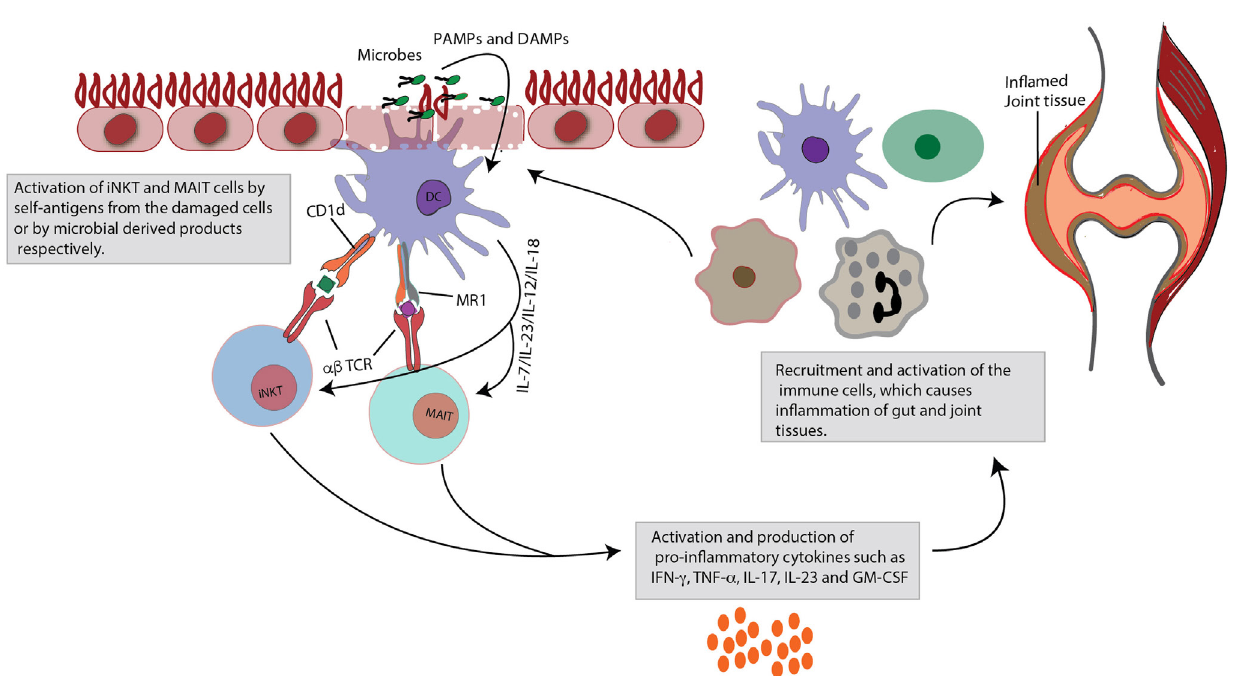
FiGURe 1 | Role of invariant natural killer T (iNKT) and mucosal-associated invariant T (MAIT) cells in gut and joint inflammation. Upon activation, iNKT cells and MAIT cells rapidly produce large quantities of cytokines. This figure focuses specifically on their pro-inflammatory effects. iNKT and MAIT cells are characterized by a semi-invariant T cell receptor (TCR), which can detect ligands of bacterial or self-origin. These antigens are presented by monomorphic MHC class I-like molecules (CD1d for iNKT cells and MR1 for MAIT cells), expressed on dendritic cells (DCs). Next to this TCR-dependent stimulation, the cells can also be activated in a TCR-independent cytokine-induced manner, that is danger-associated molecular pattern (DAMP) or pathogen-associated molecular pattern (PAMP) mediated. Activation is quickly followed by production of pro-inflammatory cytokines, such as tumor necrosis factor (TNF)- α , interferon (INF)- γ , interleukin (IL)-23, IL-17, and granulocyte-macrophage colony-stimulating factor (GM-CSF). Subsequently, these mediators will recruit and activate other immune cells, which may contribute to inflammatory diseases, such as spondyloarthritis (SpA), characterized by combined gut and joint inflammation. Contribution to inflammation may arise from impaired regulatory capacities (e.g., iNKT cells) or through skewing to pro-inflammatory profiles (e.g., IL-17).